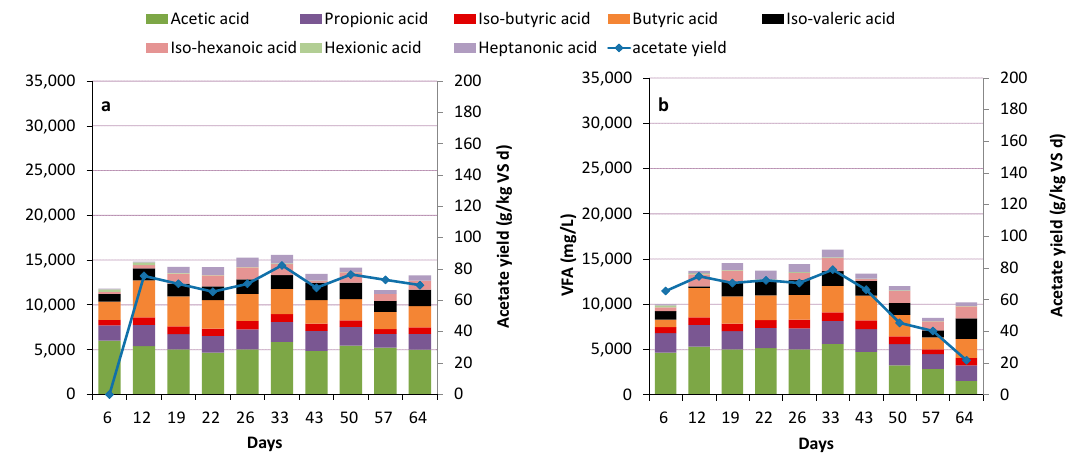
Figure 2. Volatile fatty acid (VFA) composition and acetate yield in reactors ( a ) CO-S (reactor inoculated from co-digestion plant fed with sewage sludge) and ( b ) WW-S (reactor inoculated from wastewater treatment plant fed with sewage sludge).